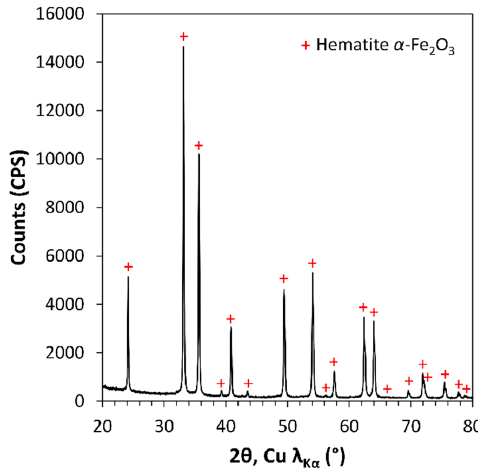
Figure 6. XRD pattern of the Fe 2 O 3 pigment. The red crosses indicate α -Fe 2 O 3 structure diffraction peaks (space group R-3C).